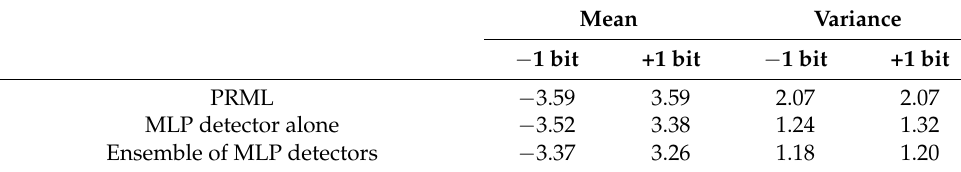
Figure 6. Probability density function of the output of PRML, MLP detector alone, and ensemble of MLP detectors at SNR of 14 dB. Table 1. Mean and variance of the models.